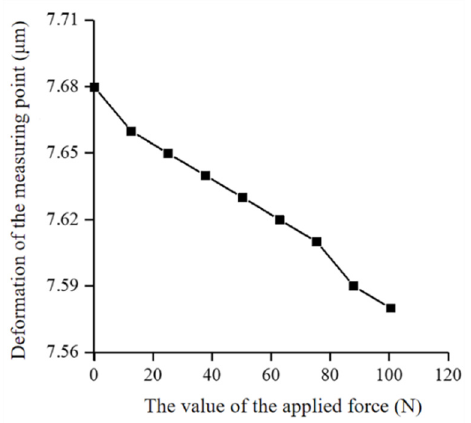
Figure 9. The deformation of the measured point varies with the applied force.